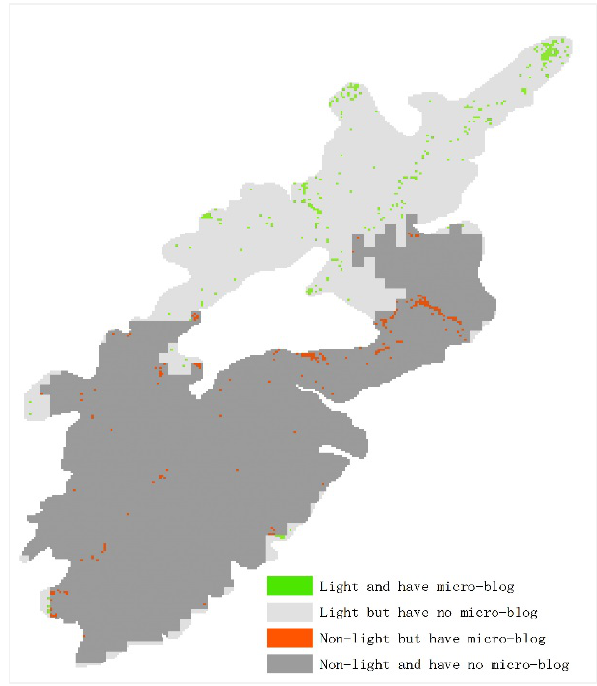
Figure 8 Distribution of microblogging in light area and non-light